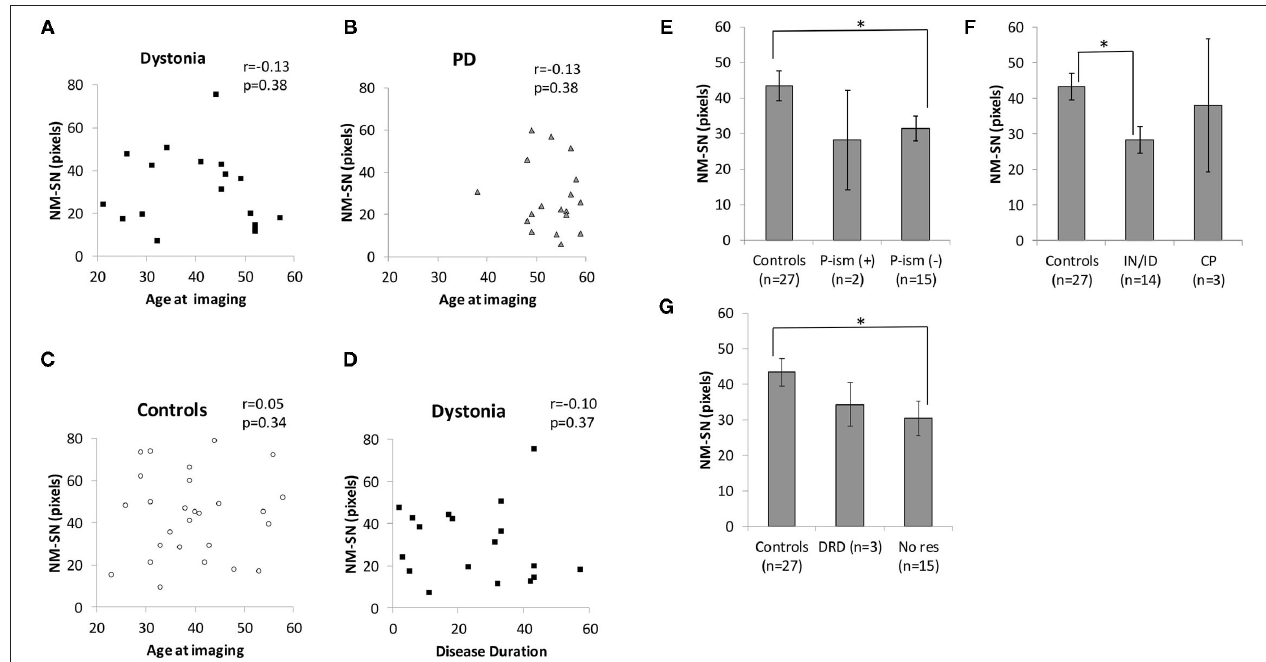
FIGURE 3 | (A) Correlation between age at imaging and the NM-SN area in the dystonia group. (B) Correlation between age at imaging and the NM-SN area in the PD group. (C) Correlation between age at imaging and the NM-SN area in the control group. (D) Correlation between disease duration and the NM-SN area in the dystonia group. (E) Comparison of the NM-SN area with the presence of Parkinsonism in the dystonia group. P-ism ( + ) refers to patients with dystonia combined with Parkinsonism ( n = 2), and P-ism (-) refers to patients with dystonia without Parkinsonism ( n = 15). (F) Comparison of etiology of the NM-SN area. IN/ID means inherited and idiopathic dystonia patients ( n = 14), and CP refers to cerebral palsy ( n = 3). (G) Comparison of the NM-SN area regarding the responsivity of levodopa. DRD refers to dopa-responsive dystonia ( n = 3), and No res refers to no responders to levodopa ( n = 15). Error bars indicate SEM. *Statistically significant difference ( p < 0.05). NM-SN, neuromelanin-substantia nigra; DRD, dopa-responsive dystonia; PD, Parkinson’s disease; CP, cerebral palsy; SEM, standard error of the